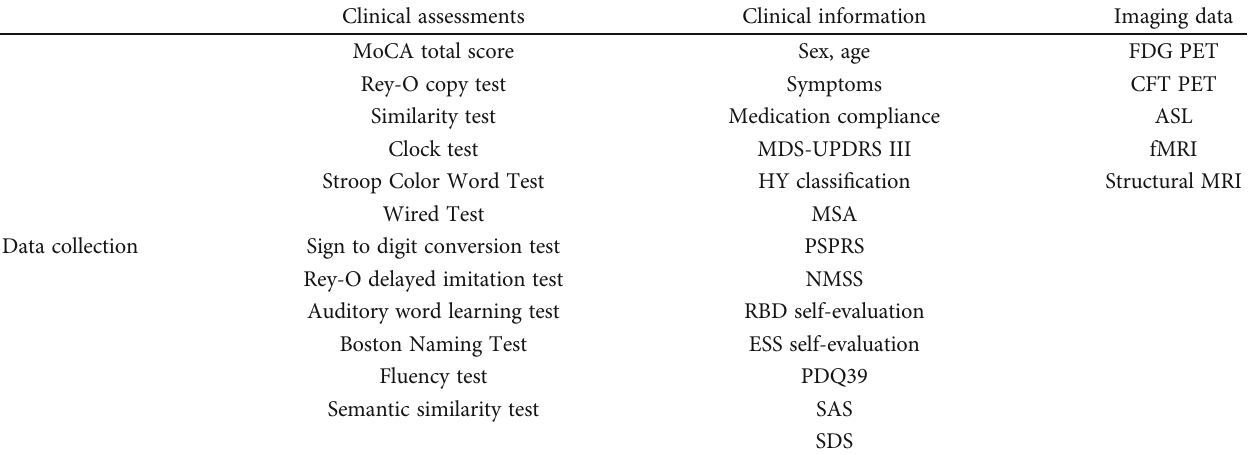
Table 1: Clinical examination items of